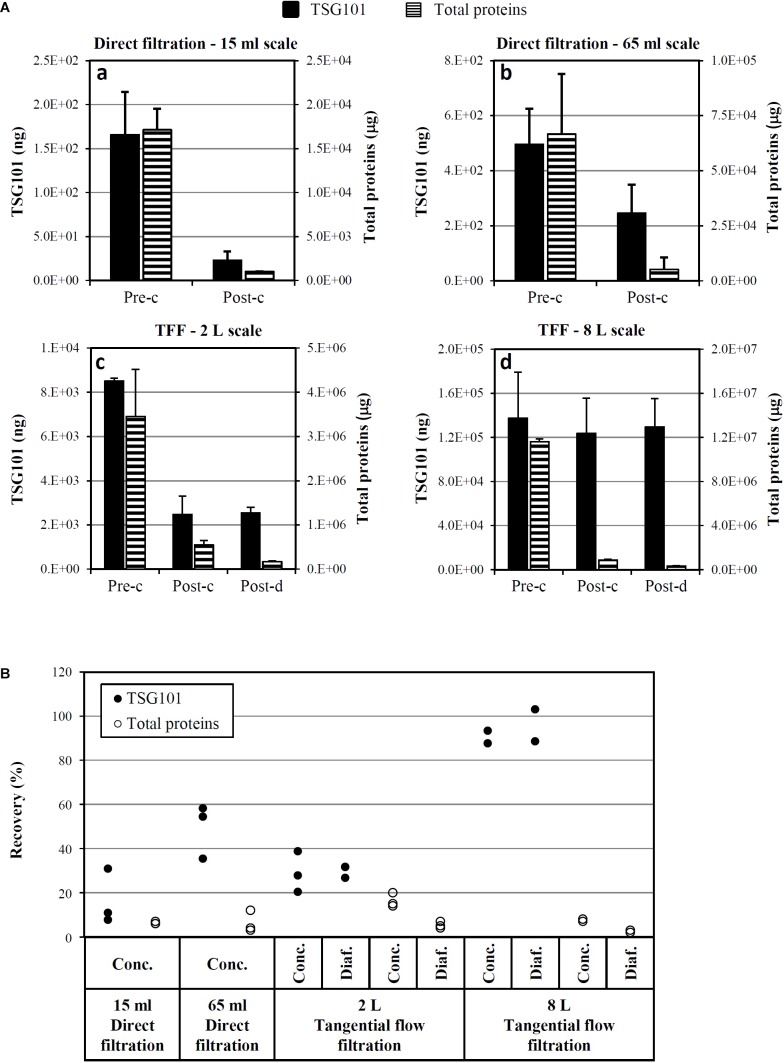
Optimization and scale-up of Exo-CPC isolation. (A) Quantitative analysis of TSG101 and total proteins before and after concentration (a–d) and diafiltration (c,d) by different techniques. Mean + SD with n = 3 (a–c; CM collected after 1 week starvation) or n = 2 (d, CM collected after 2 weeks starvation). (B) TSG101 and total protein recovery as a percentage of the quantity measured in the initial CM (pre-concentration). Each dot is the result of an independent experiment. Pre-c, before concentration; post-c, after concentration; post-d, after diafiltration.